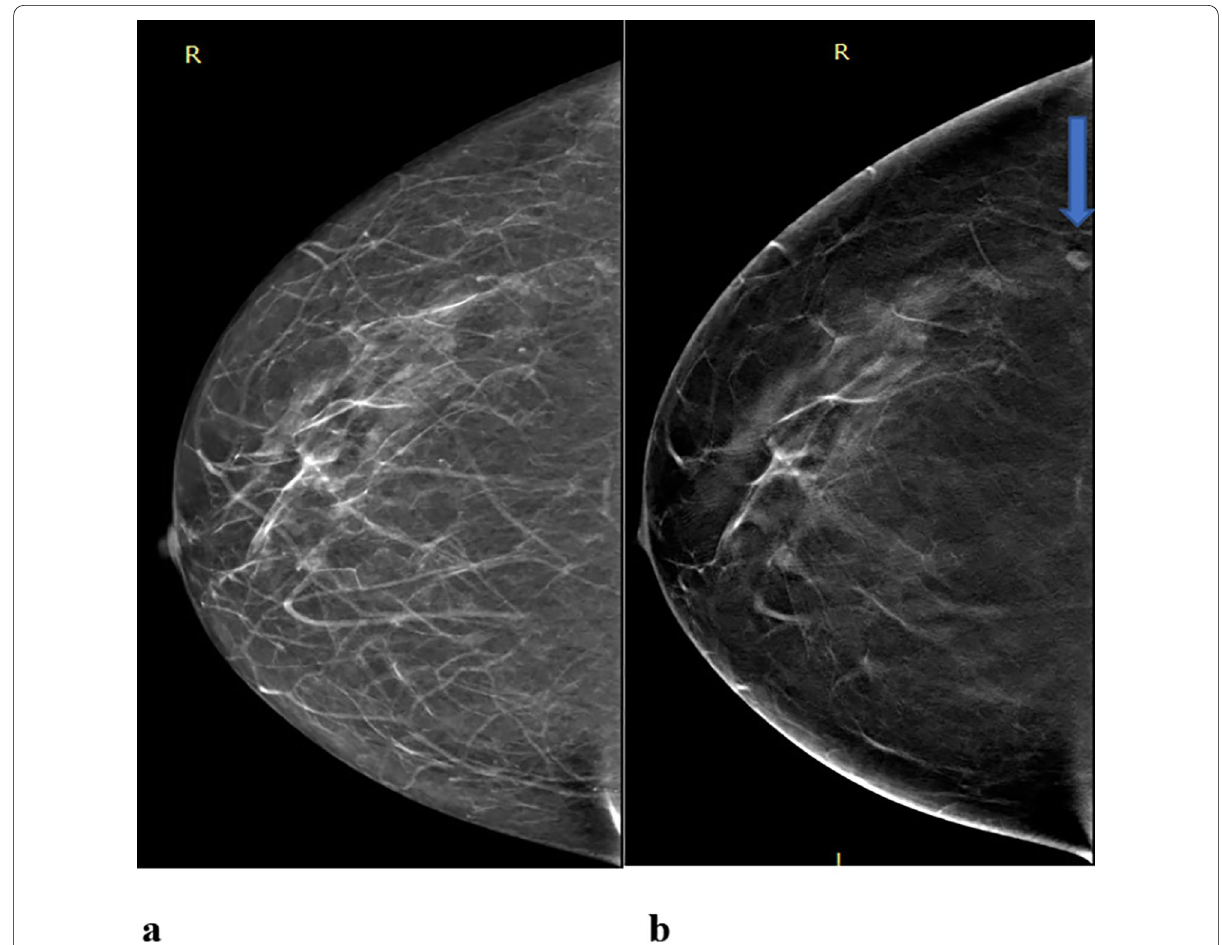
Fig. 4 A 65-year-old female came for follow-up after left breast MRM followed by Chemotherapy and Radiotherapy. a CC view 2DDM of the right breast shows predominantly fatty breast (ACR a) with hardly detected lesion in outer quadrant. b CC view DBT of the right breast shows circumscribed oval dense mass in outer quadrant with hypo attenuated fat content. BIRADS 2, proved by histopathology to be intramammary lymph